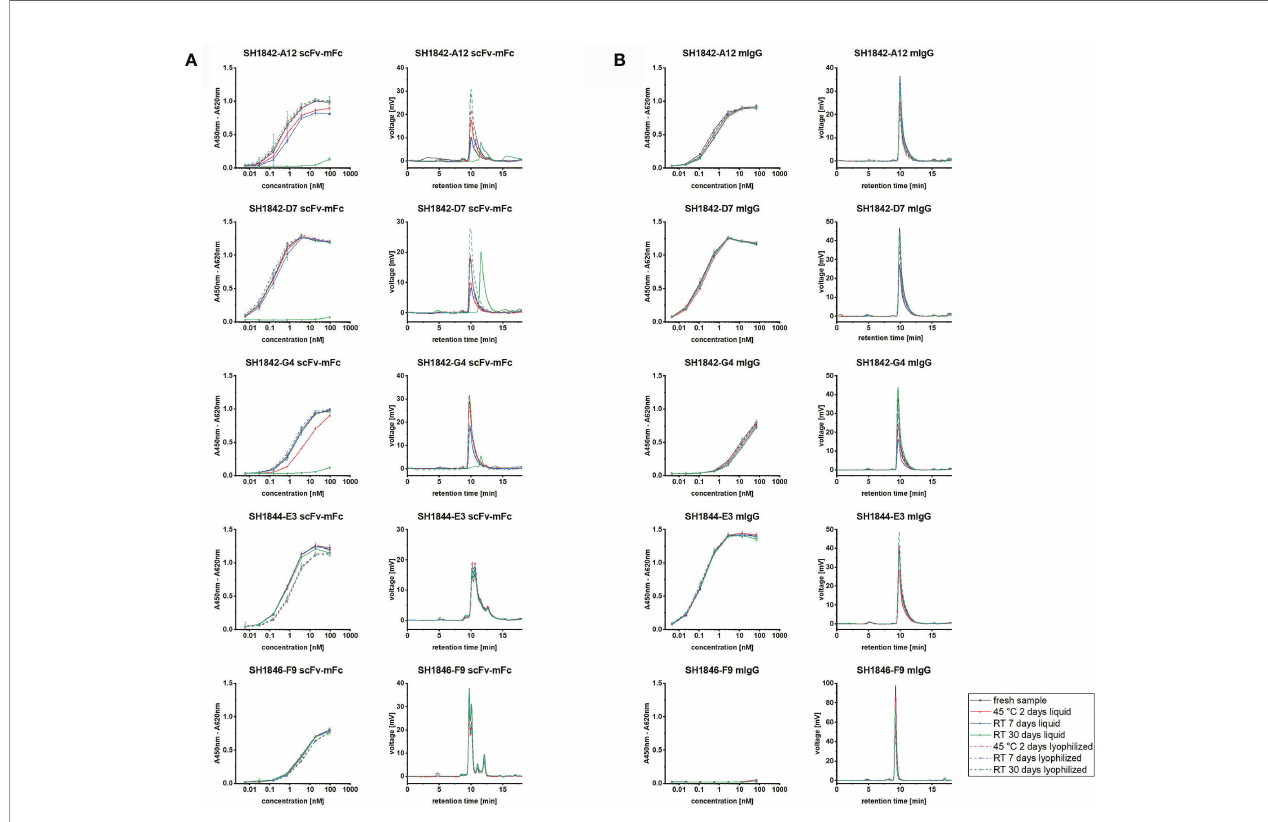
FIGURE 5 | Storage stability of scFv-Fc or IgG antibodies. Upon storage at RT or 45°C, respectively for 7-30 or 2 days, in liquid (solid lines) or freeze-dried (dashed lines) state, fi ve antibody clones were studied for their residual binding activity in ELISA and MM distribution in SE-HPLC in (A) scFv-mFc2a format or (B) full mIgG2a format. For SE-HPLC are shown representative chromatograms for each condition. ELISA curve error bars result from the analysis of 3 independently lyophilized or liquid stored samples.